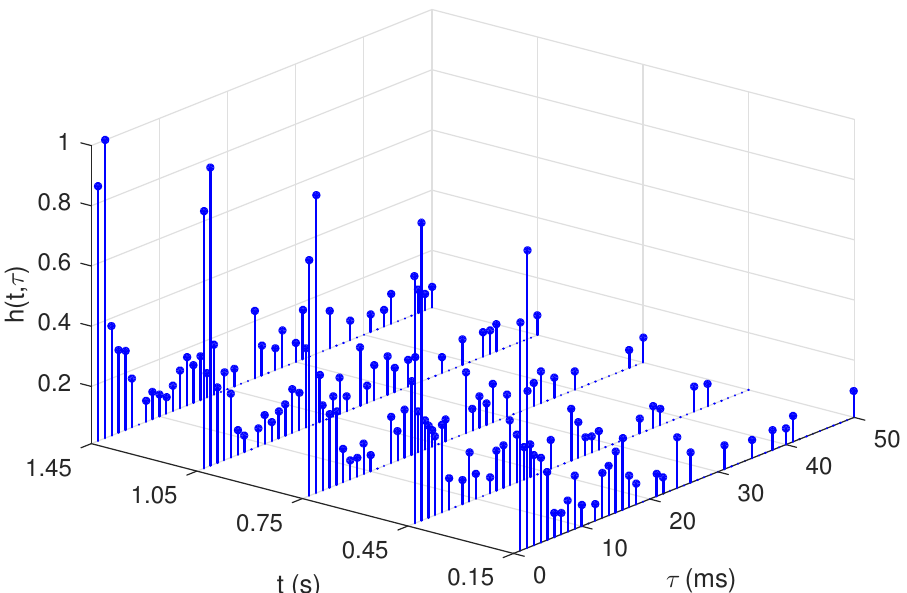
Figure 7. The channel impulsive responses from the pool